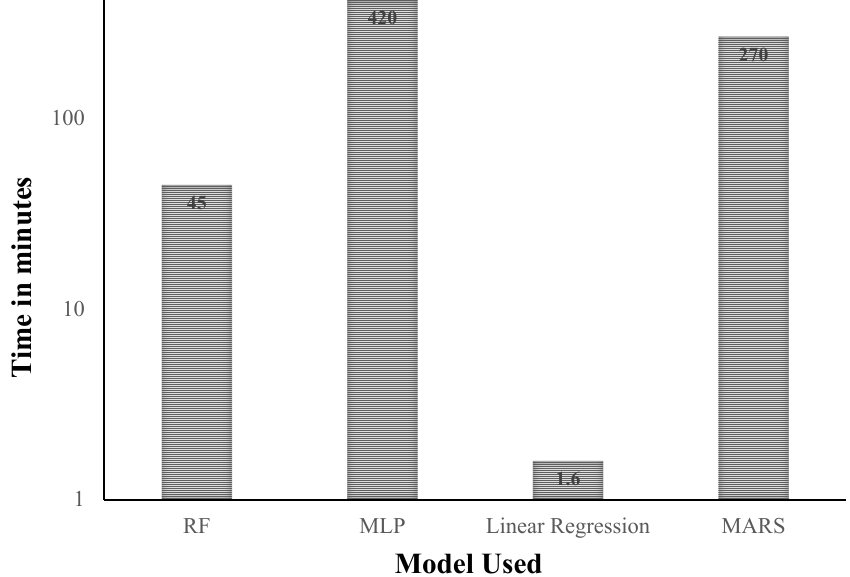
Figure 5. Model training time for different regression methods.